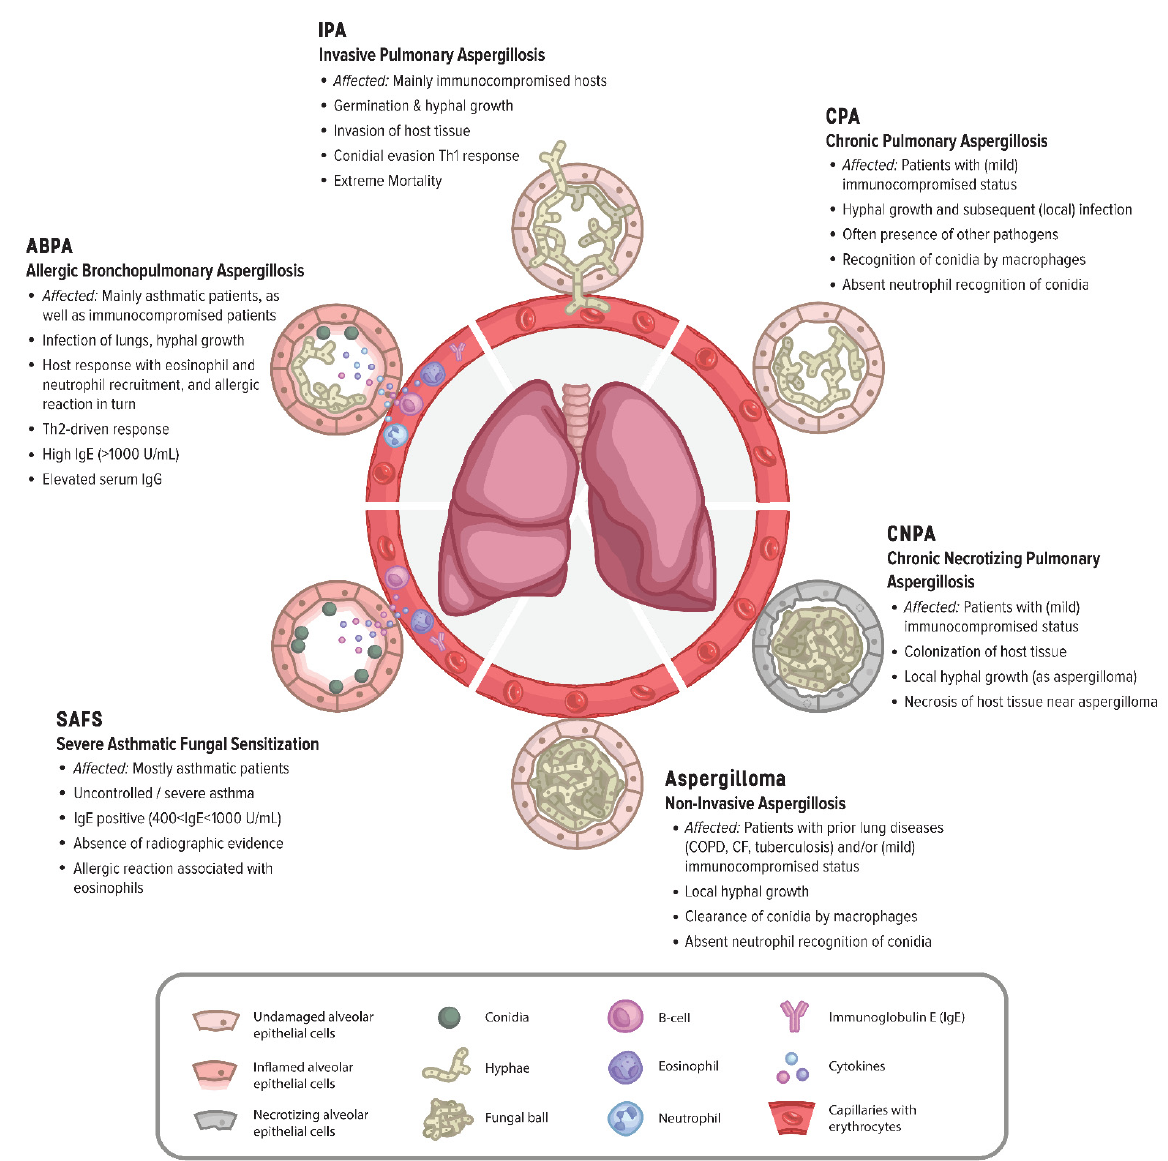
Figure 1. Schematic overview of common lung diseases caused by Aspergilli. Representative alveoli, capillaries with red blood cells and immune cells involved in the direct pathology of aspergilloses such as allergic bronchopulmonary aspergillosis (ABPA) and severe asthma with fungal sensitization (SAFS).